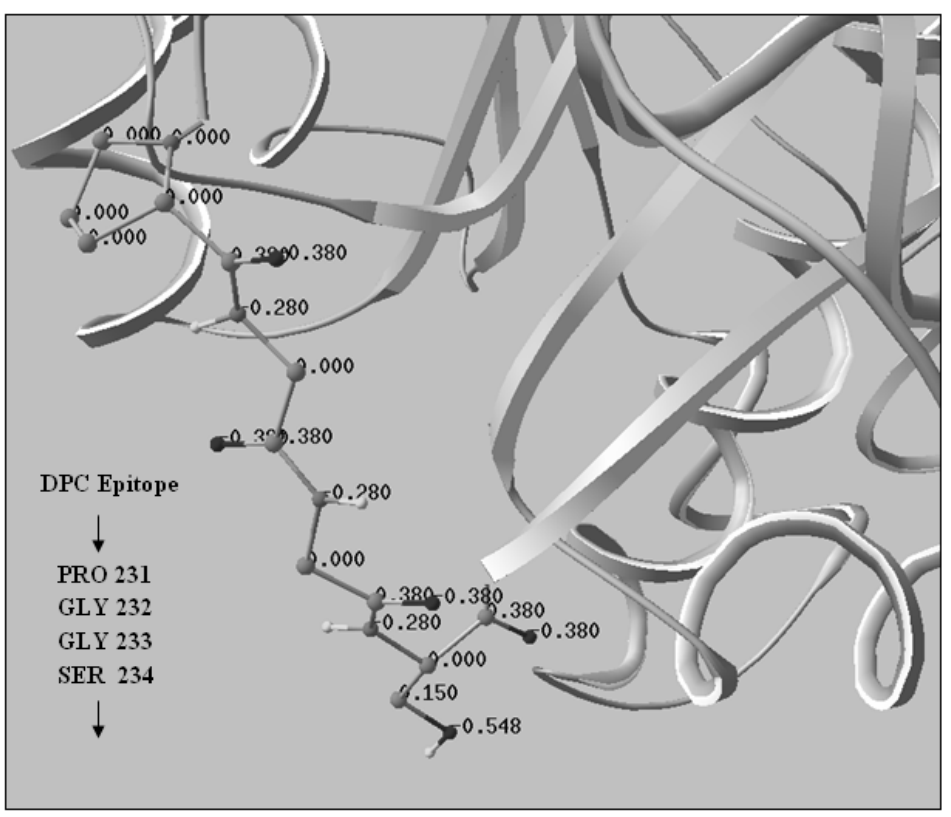
Figure 11: The partial electric charges of the atoms from the epitope residues. The distribution of the electric charges in the epitope residues is helpful for the interpretation of the interactions responsible for